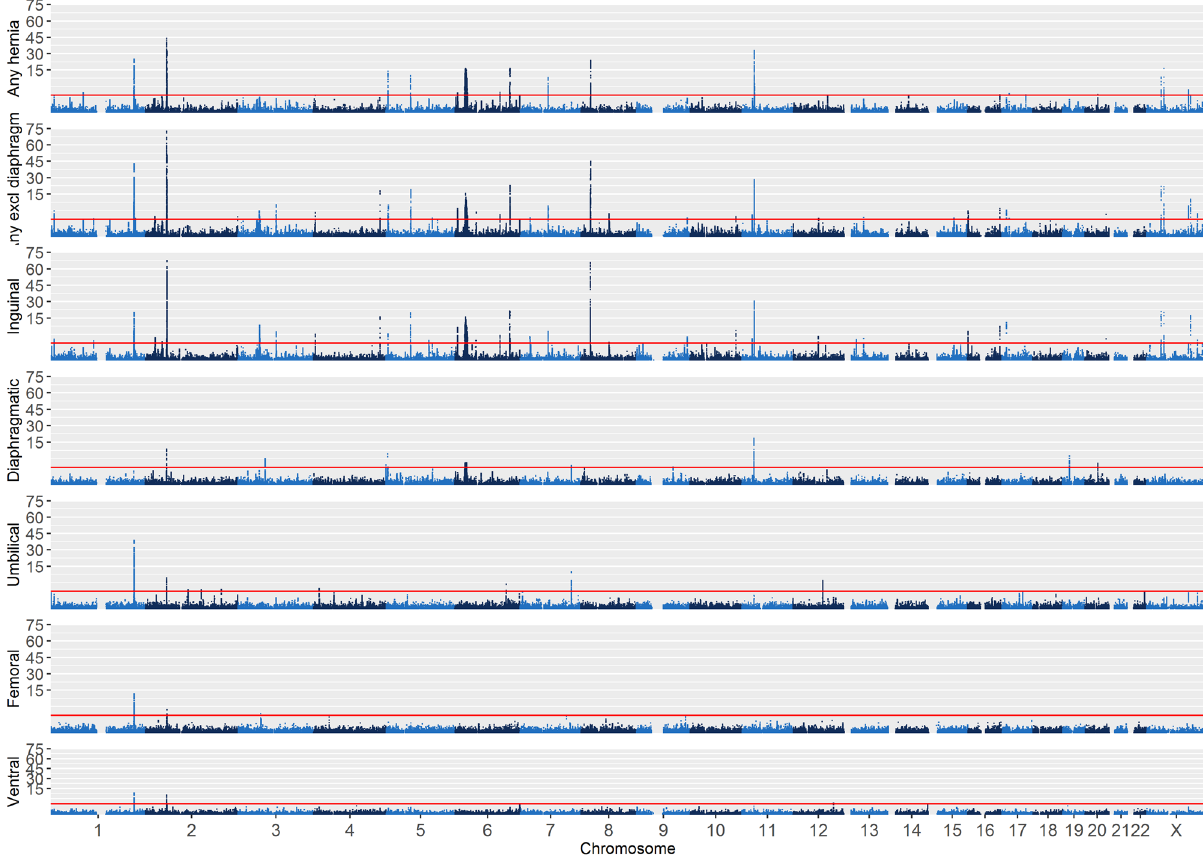
Fig. 2 Manhattan plots for SAIGE GWAS scans. Manhattan plots for the 7 analyzed hernia groups, displaying – log 10 ( P values) from the SAIGE analyses over the chromosomes. The scale for the y-axis is shrinked by a factor of 5 for values above 15. The red line indicates the P threshold for genome-wide signi fi cance of 5 × 10 − 8